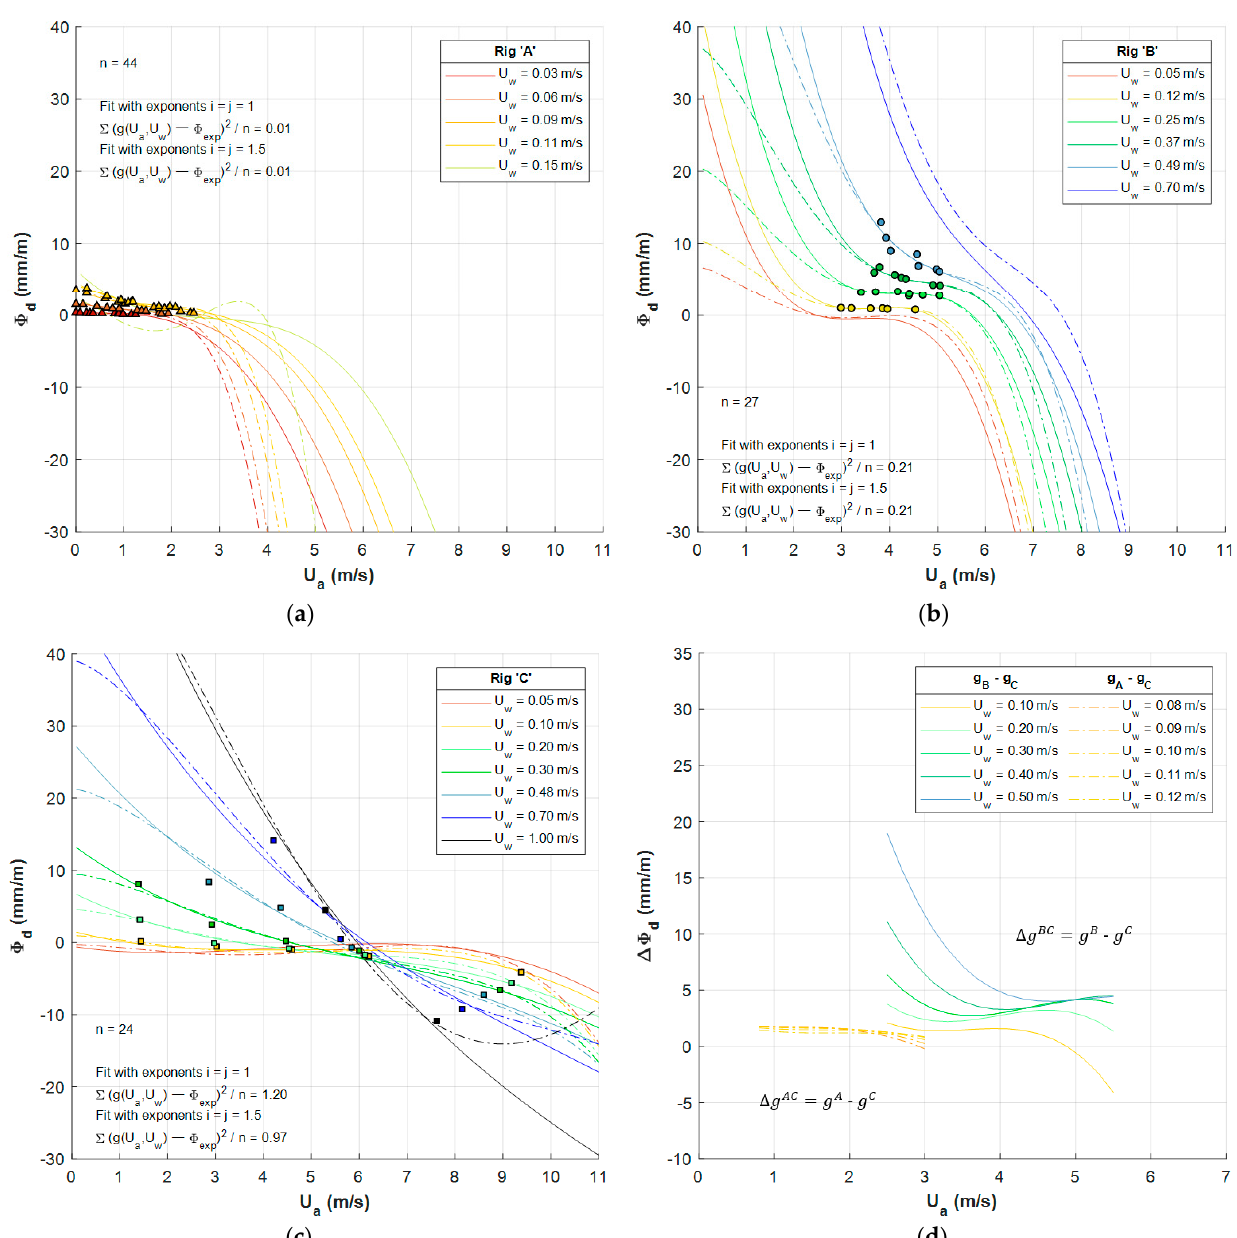
Figure 9. Empirical correlations for the Φ d pressure gradient component defined by Equation (7). ( a ) Correlation for Rig ‘A’ dataset; ( b ) Correlation for Rig ‘B’ dataset; ( c ) Correlation for Rig ‘C’ dataset ( d ) Comparison between correlations, for regions of overlap indicated in Figure 2.